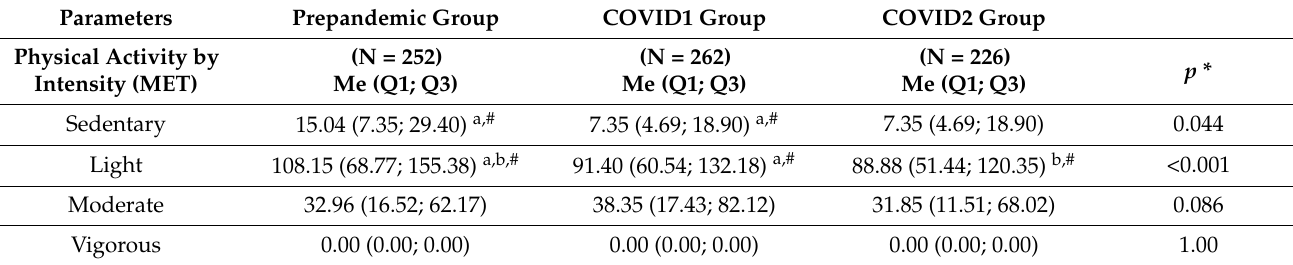
Table 1. The intensity of physical activity in the studied